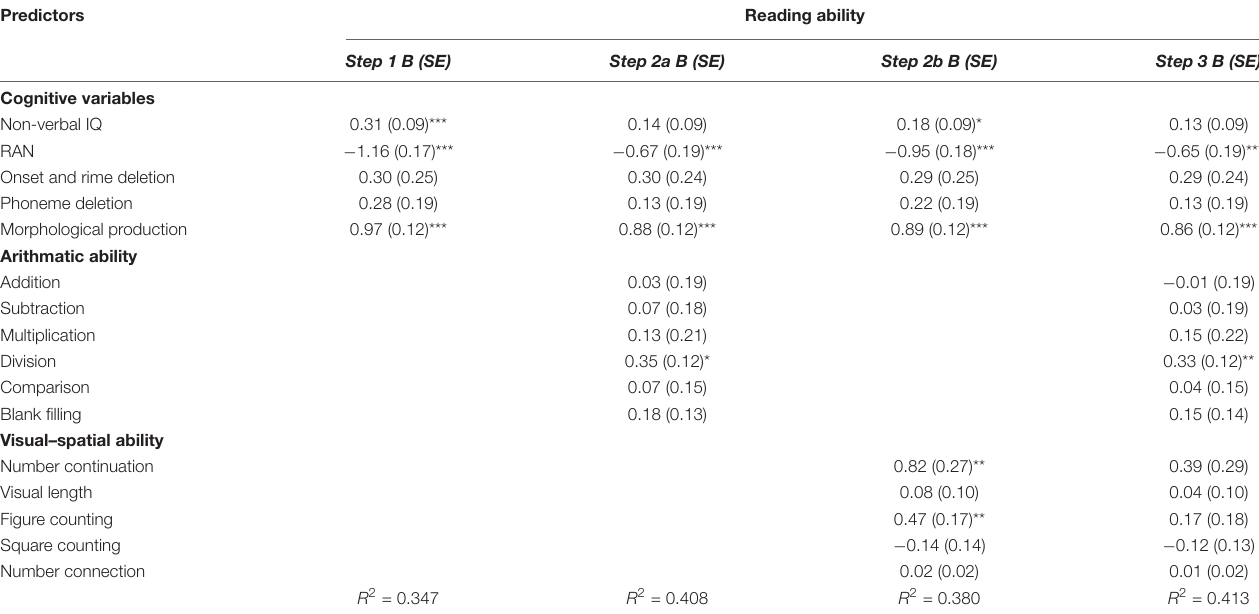
TABLE 3 | Hierarchical regression models of reading ability predicted by visual–spatial ability and arithmetic ability.